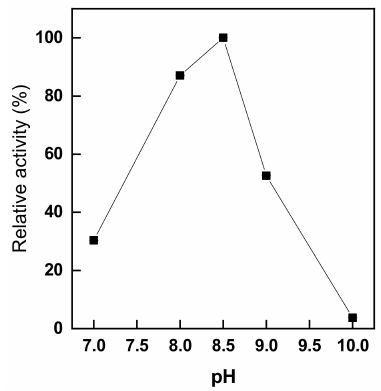
Figure 3. The e ff ects of pH on the immobilization of trypsin onto glutaraldehyde-pre-activated chitosan nonwoven (trypsin immobilization: trypsin conc. 10% (owf), 1 h, 25 ◦